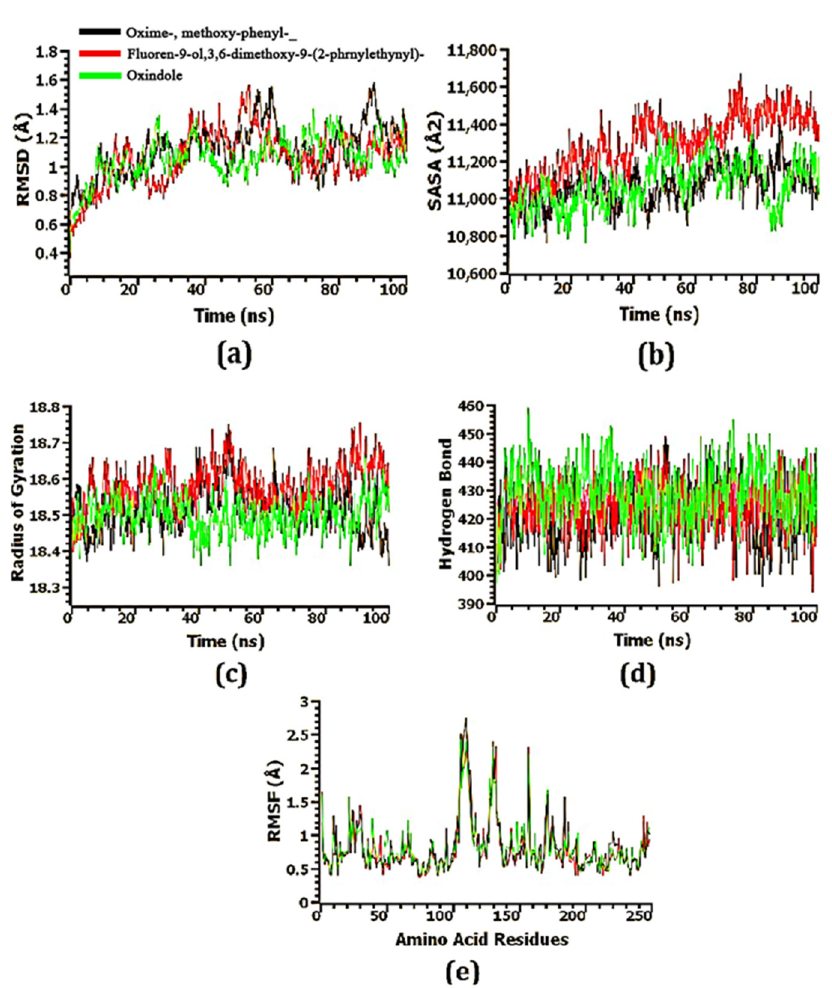
Figure 8. The molecular dynamics simulation of the top 3 docked complexes. ( a ) RMSD, ( b ) SASA, ( c ) radius of gyration, ( d ) hydrogen bond, and ( e ) RMSF.